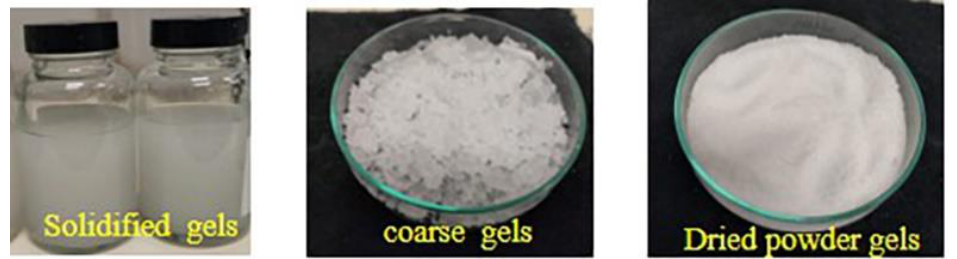
Figure 1. Processed fine powder of PVDF gels.